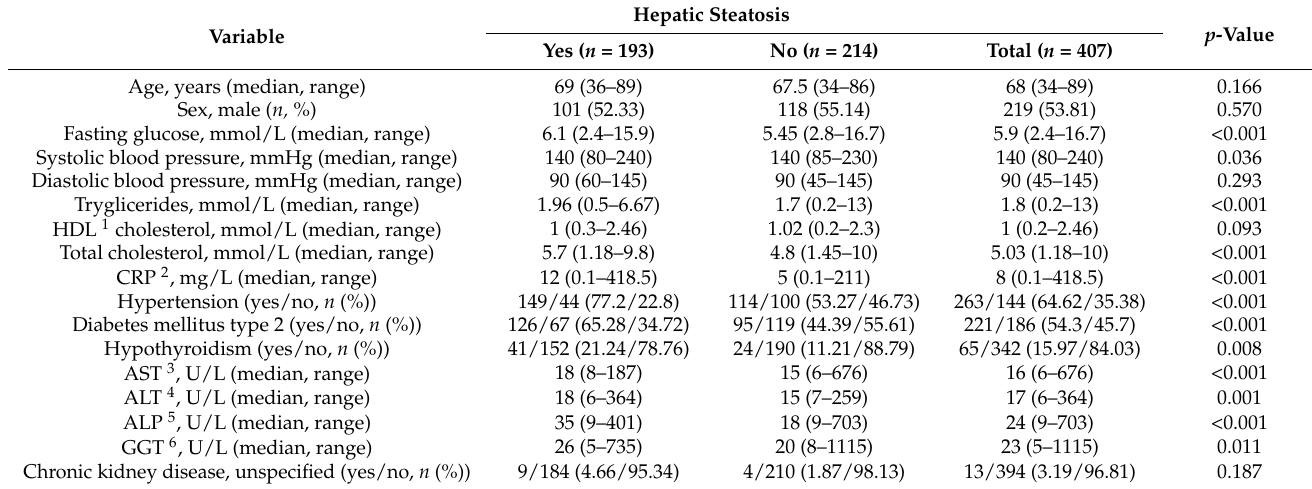
Table 1. Characteristics of the study population concerning the concomitant presence of hepatic steatosis.